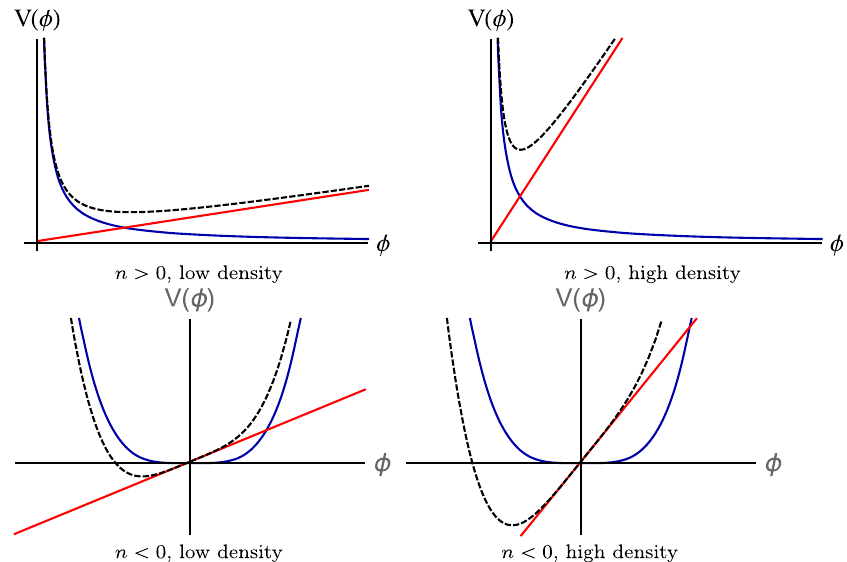
Fig. 1 Sketches of the chameleon effective potential for positive n (upper panels) and negative n (lower panels). The left and right panels show the cases of low and high density environments respectively. The blue lines show the bare potential and the red lines show the contribution from the coupling to matter. The black dashed lines show the resultant effective potential, which is the sum of the red and blue lines,